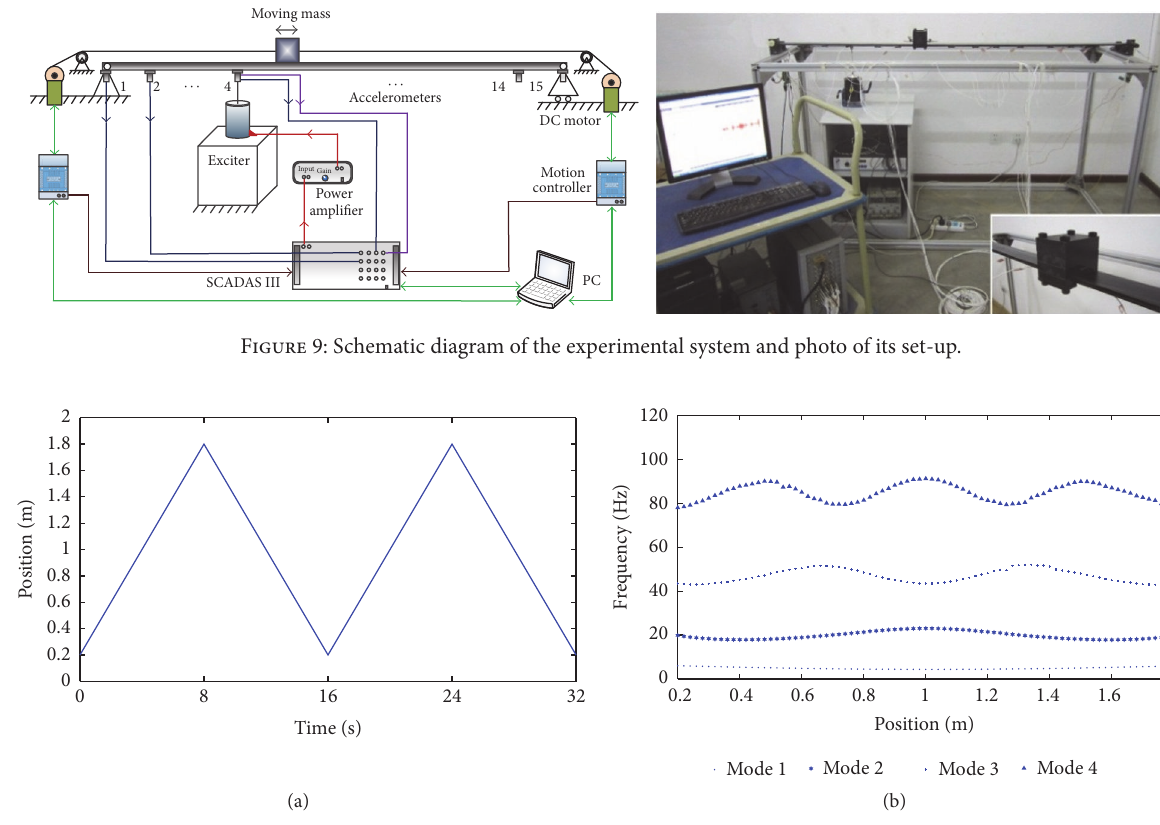
Figure 10: The motion form of the moving mass and the corresponding first four baseline natural frequencies of the experimental system: (a) motion form and (b) baseline natural frequencies.